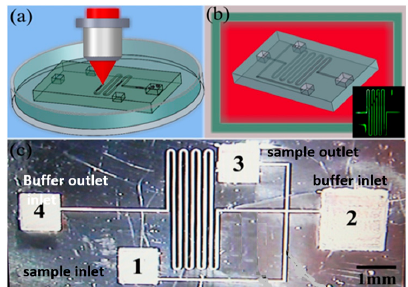
Figure 15. Flow chart of fabrication procedures: ( a ) laser direct writing inside porous glass and ( b ) annealed in a furnace. Inset: fluorescence microscopy image of the microchannel filled with a solution of fluorescein; ( c ) optical micrograph of the fabricated electrophoresis microchip.